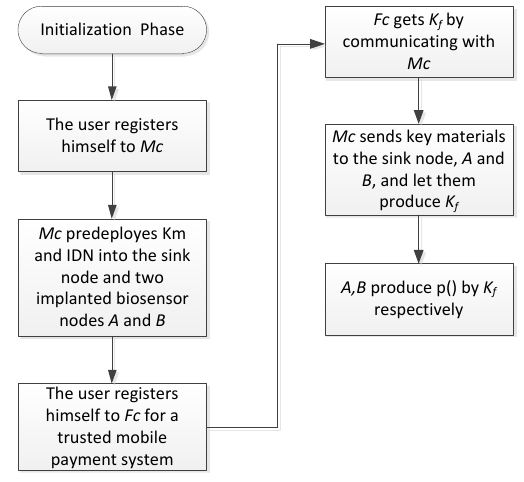
Figure 3. The process of